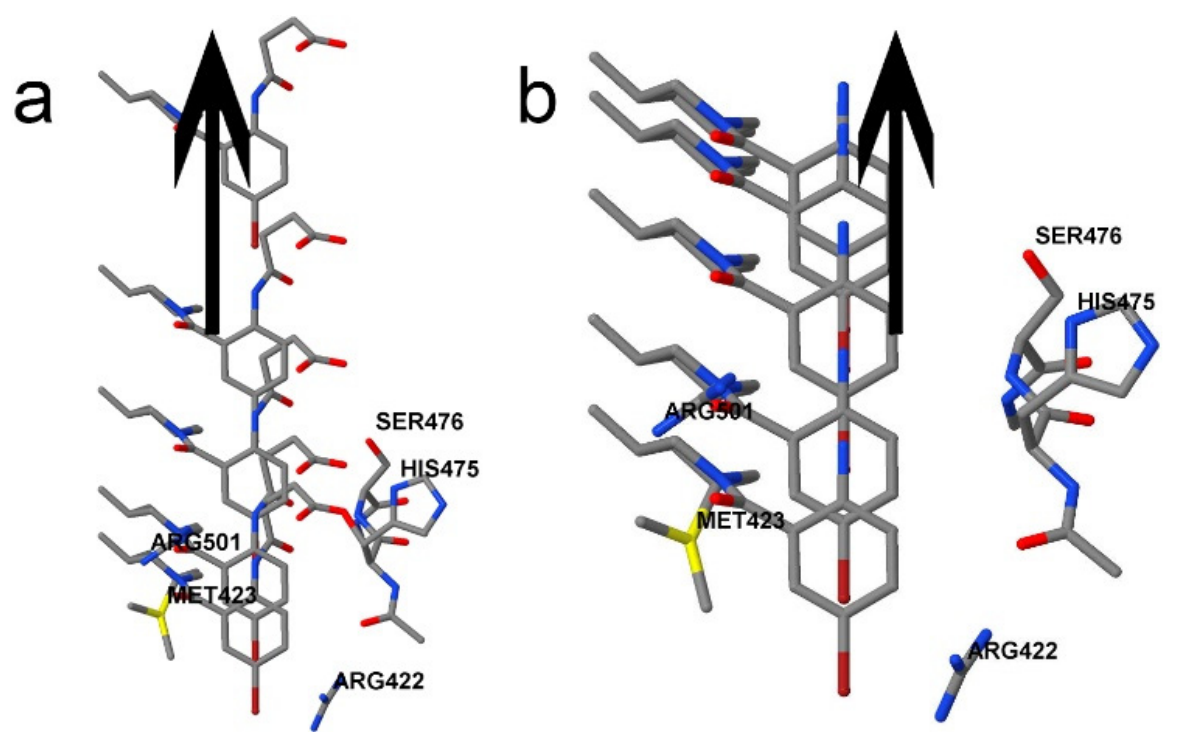
Figure 3. The REG control coordinate. The pocket model is fixed, and different configurations were obtained where the ligand is closer to the pocket than in the PDB file, and others where the ligand is farther than in the PDB file. IQA data are calculated for every atom, and every atomic pairwise interaction, for every configuration. The changes in the IQA energy terms allow highlighting the most important ones. This picture only shows 5 different snapshots along the control coordinate. ( a ) The 3CJ4 ligand contains 117 atoms, and contains an extra succinic acid, which gives it a charge of − 1. The charge of the pocket is +3, which creates a total of +2 for the system. ( b ) The 3CJ2 ligand does not contain the negatively charged acid moiety, so the charge of the system remains +3.